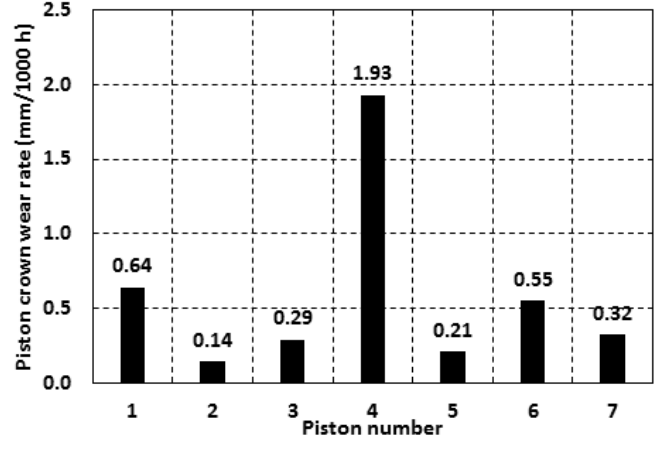
Figure 9. Piston crown wear rate.